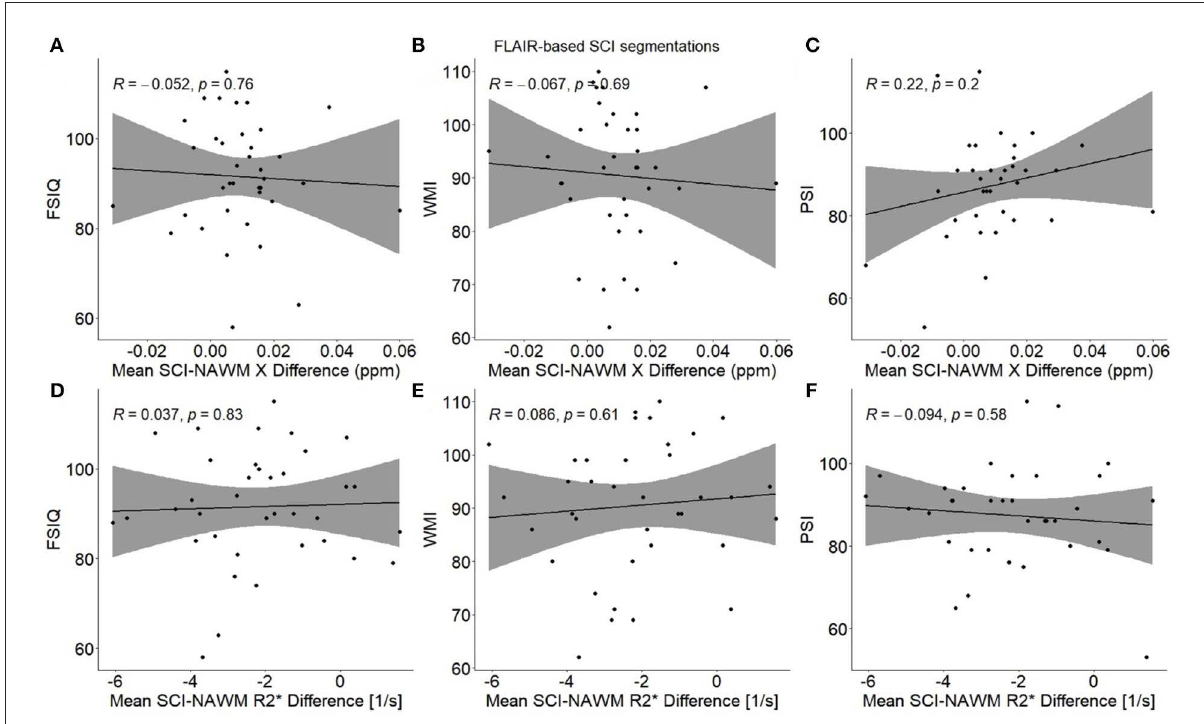
FIGURE9 Association between participant mean SCI–NAWM χ and R * 2 differences and measures of cognitive performance. Within each participant, mean silent cerebral infarcts (SCI) χ and R * 2 differences relative to normal appearing white matter (NAWM) were calculated across all lesions, and associations were examined with full scale IQ (FSIQ) (A,D) , working memory index (WMI) (B,E) and processing speed index (PSI) (C,F) . No significant associations were observed between SCI–NAWM χ and R * 2 and any measures of cognition. SCI were segmented using the FLAIR-based SIT trial